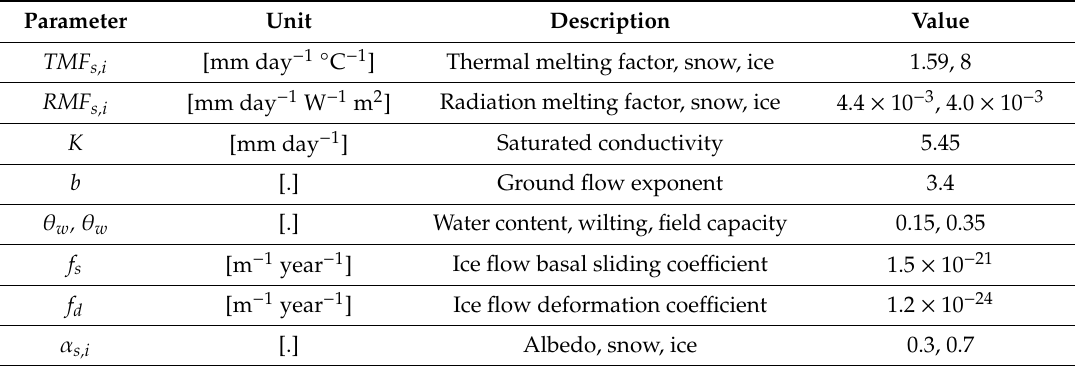
Table 2. Tuning parameters for Poli-Hydro. Thermal melting factor and radiation melting factor are both reported for ice and snow, as well as the albedo. Parameters calculated by the authors, using the Poli-Hydro model.